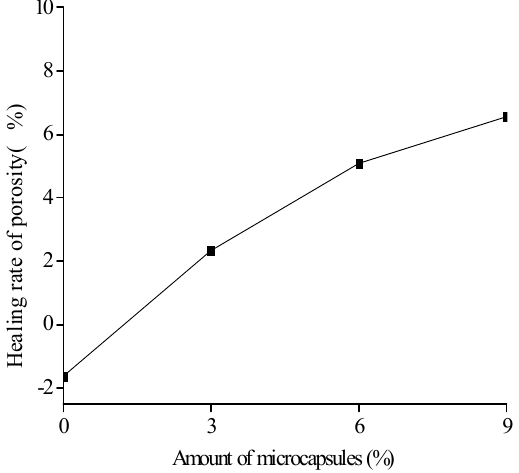
Figure 18. Healing rate (Equation (7): η (cid:3017) ) of porosity with amount of microcapsules.